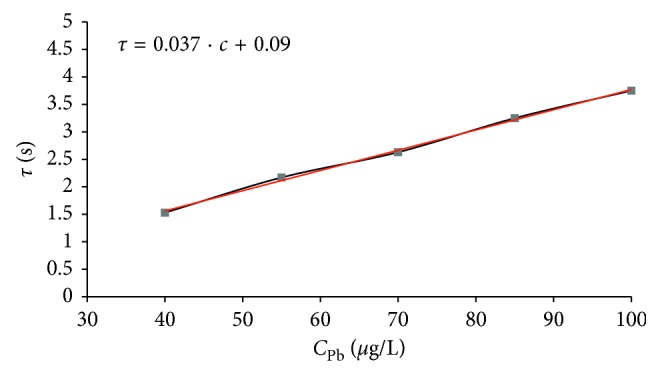
Linearity of lead analytical signal (tdep = 120 s; trp = 60 s; iR = 10.0 μA; Q = 13.2 ml/min).